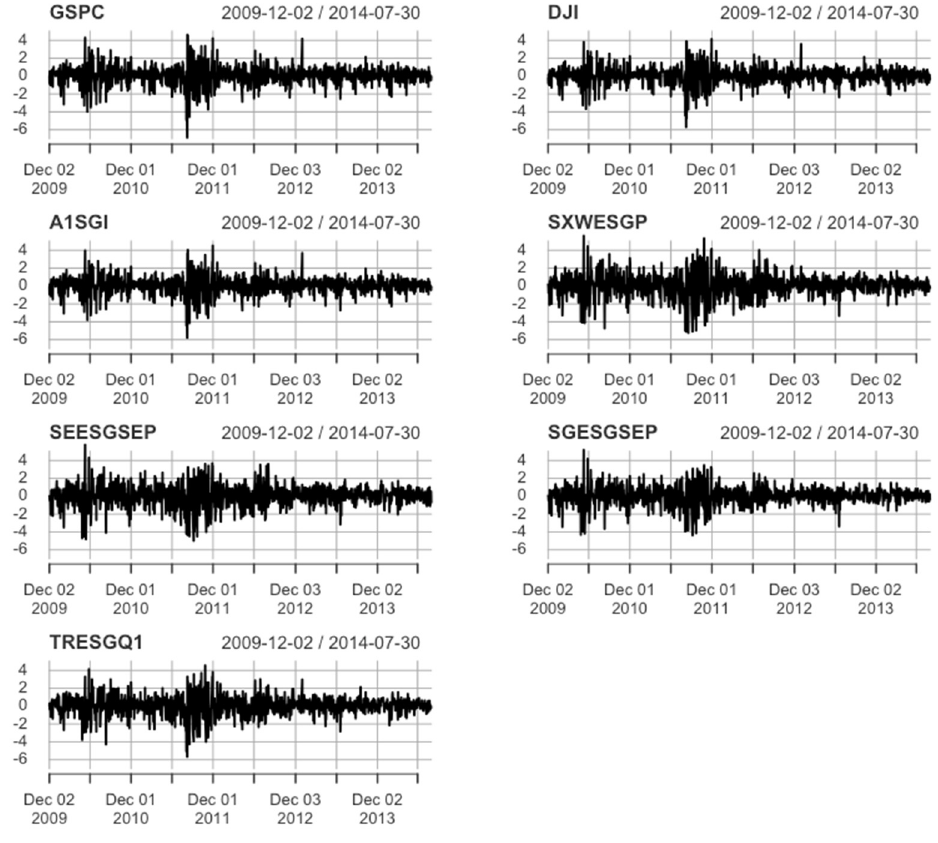
Figure 3. The rates of return, 2 December 2009–30 July 2014.